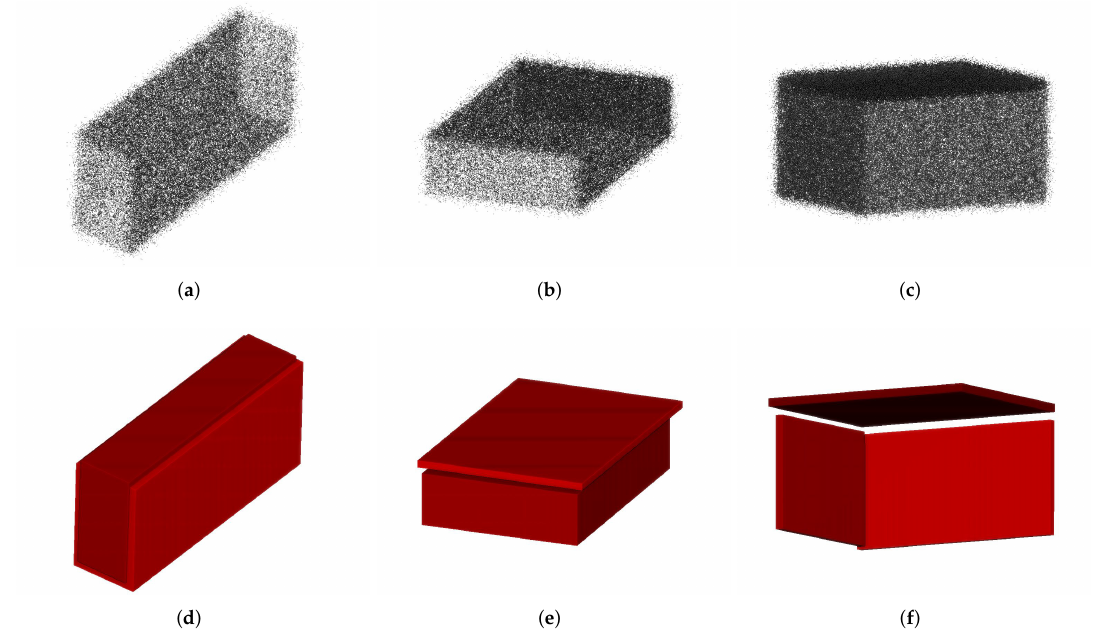
Figure 5. Types of multiple cuboid modeling from point clouds of a single cuboid by Wei et al. [10]. ( a – c ) Arbitrarily chosen synthetic data with which multiple cuboids are generated and ( d – f ) corresponding modeling results. ( a , d ) Case in which multiple cuboids of slightly different sizes are overlapped. ( b , e ) Case in which one plane is modeled as a cuboid and the remainder point clouds are modeled as another cuboid. ( c , f ) Case in which each plane is modeled as a